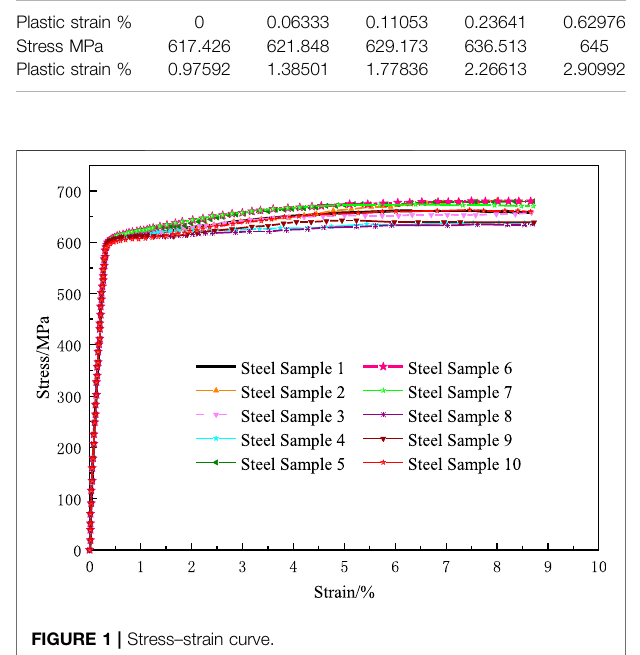
FIGURE 2 | Weld geometry